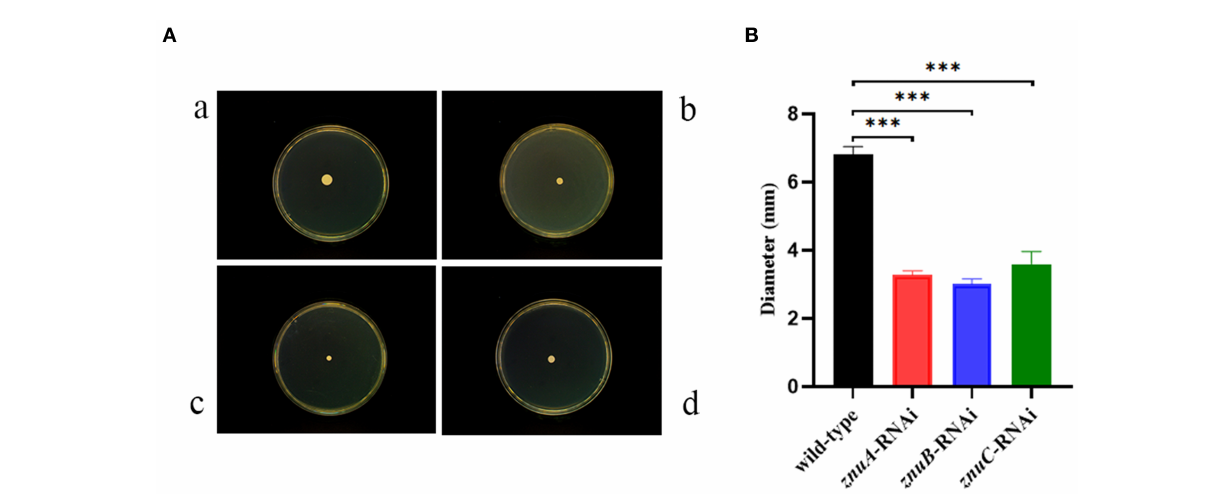
FIGURE5 Single colony motility assay of wild-type and znuA-RNAi, znuB-RNAi, znuC-RNAi of A. salmonicida SRW-OG1. (A) was the typical observation of plate movement of the wild-type (a), znuA -RNAi (b), znuB -RNAi (c) and znuC -RNAi (d) strains; (B) was the colony diameter histogram. Data were presented as mean ± standard deviation (SD) ( n = 3). *** P < 0.001.